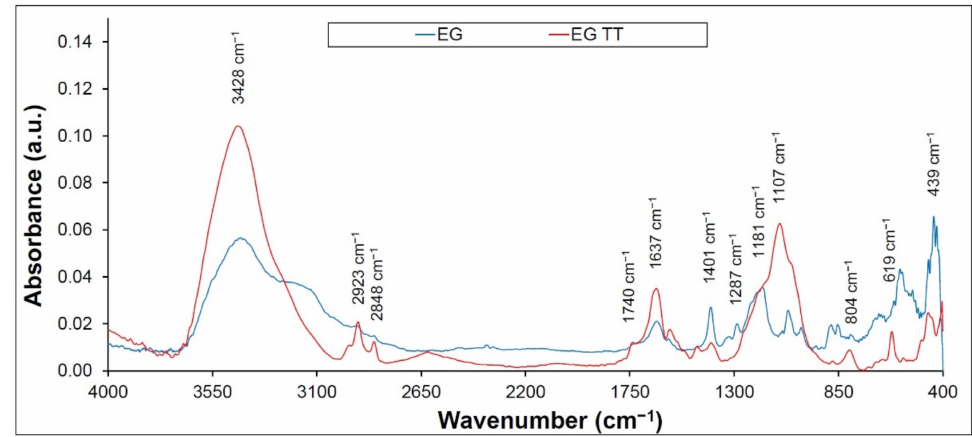
Figure 7. FTIR spectra of expanded graphite before (EG) and after thermal treatment (EG